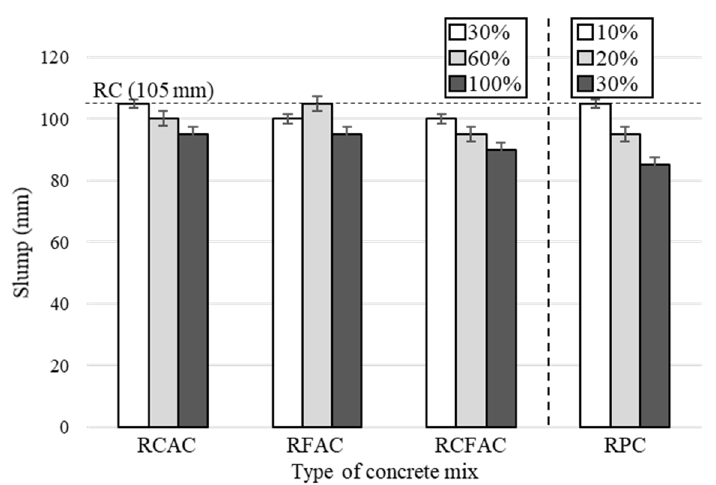
Figure 2. Slump test of concrete mixes made of recycled aggregates and recycled powder.